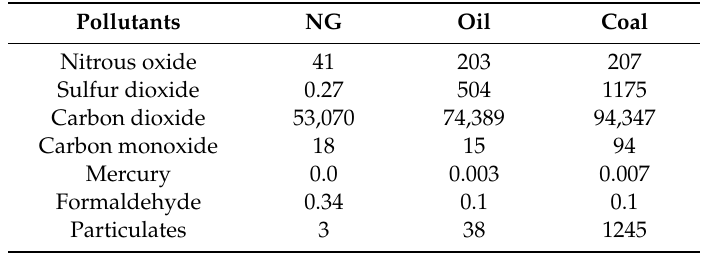
Table 1. Air pollutants emission per billion kJ energy production (in kg) [5]. Pollutants NG Oil